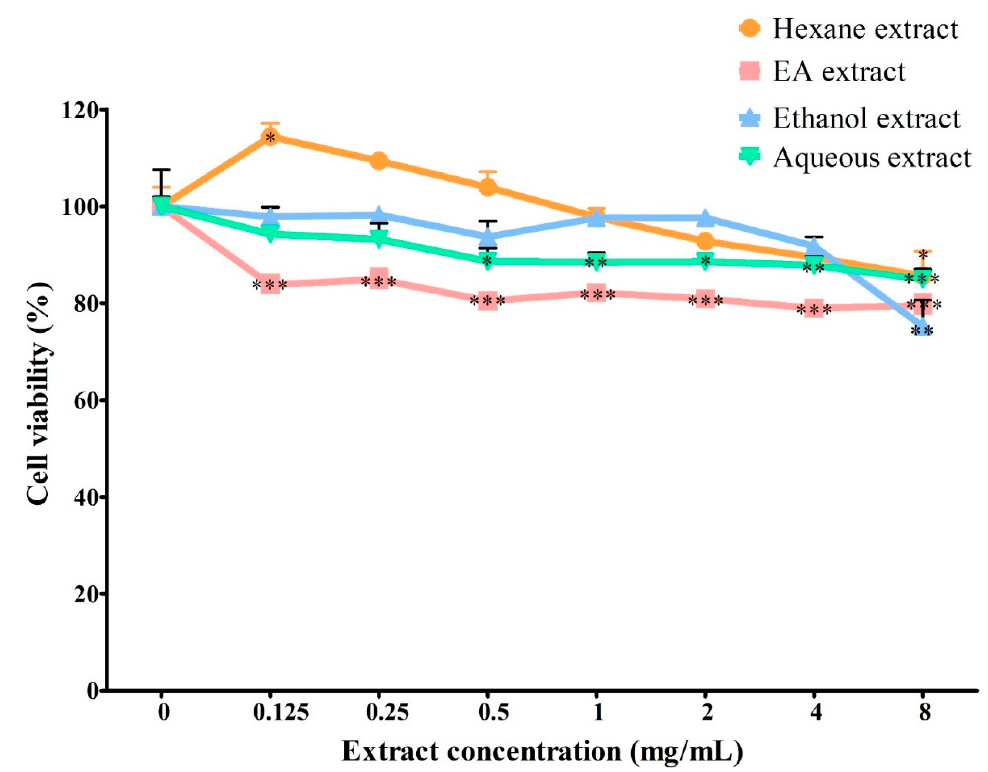
Figure 2. Effect of S. platensis extracts on cell viability in BV2 microglia. The cell viability was ex- pressed as a percentage of the negative control (0 mg/mL). Data represent the mean ± SE ( n = 3). *** p ≤ 0.001, ** p ≤ 0.01 and * p ≤ 0.05 significant difference in cell viability relative to the negative control by Dunnett’s multiple comparison test. EA: ethyl acetate.